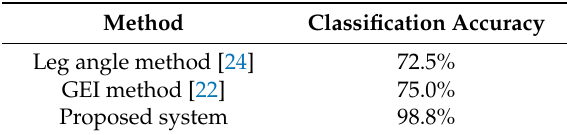
Table 3. Classification accuracy of the proposed and state-of-the-art systems.